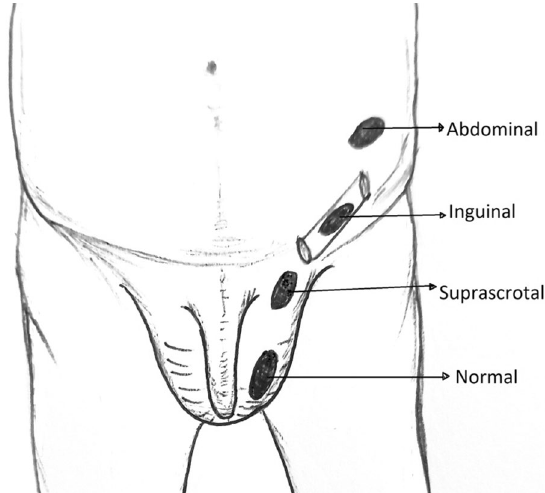
Fig. 3 Diagrammatic schema showing the locations of cryptorchid testis along the normal course of